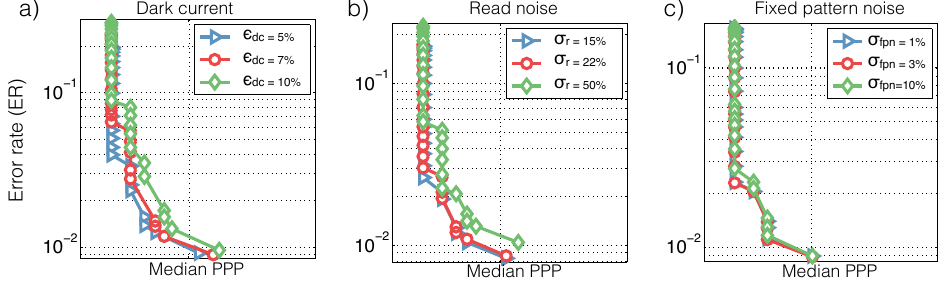
Figure 4. Sensitivity to noise in image classification. Error rate vs . PPP tradeoff with different levels of ( a ) dark current (cid:101) dc , ( b ) read noise and ( c ) fixed pattern noise (see Section 3.1). The default setting uses 3% dark current, 0% read noise and 0% fixed pattern